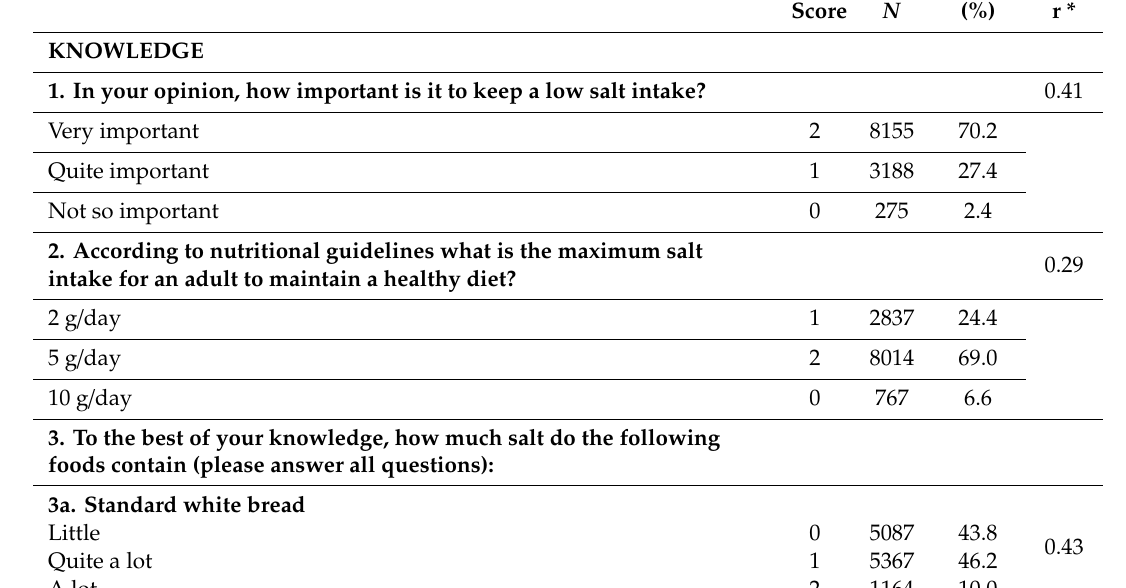
Table A1. Questionnaire items on knowledge and behaviour about salt consumption and adherence to the Mediterranean Diet. Replies to single questions by response categories [n (%)] and relevance of each question (r) to the overall assessment of the knowledge score and the behaviour score. The questionnaire is available in Italian on